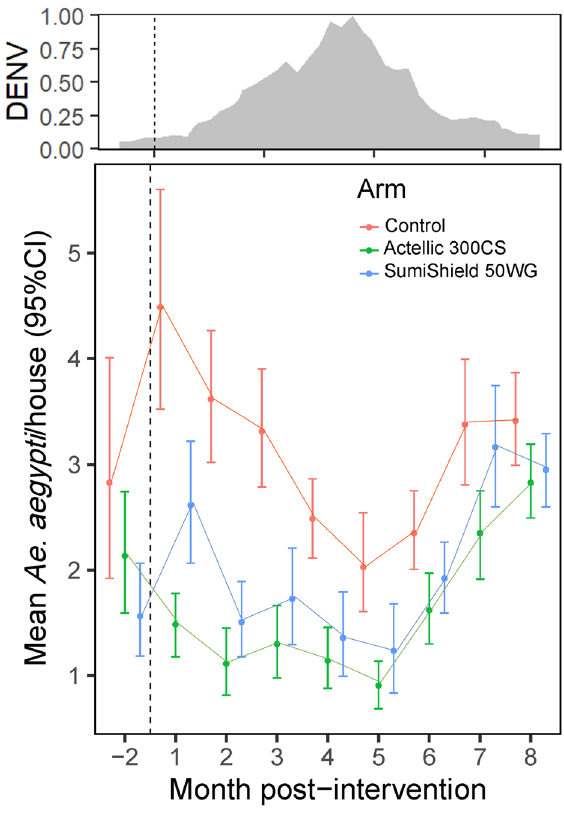
Figure 2. Impact of pre-season TIRS on Ae. aegypti density. Estimated mean (± 95%CI) number of Ae. aegypti adults per house at baseline (April) and 1–8 months (July 2019-January 2020) post-TIRS application of two long-lasting residual insecticide formulations in Merida, Mexico. TIRS was conducted in June (dashed vertical line), prior to the regular arbovirus transmission season. Top panel shows the standardized incidence of dengue from 1991–2001 in Yucatan, with values closer to 1 indicating periods of high transmission and values closer to 0 of low